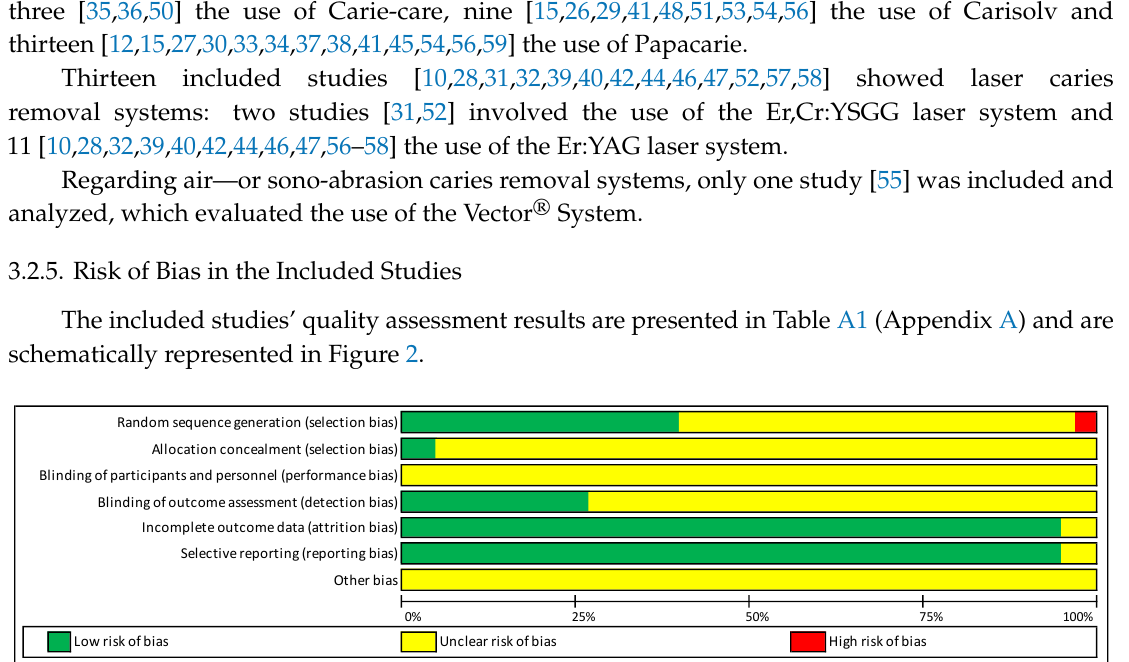
Figure 2. Schematic representation of the included studies methodological quality assessment.